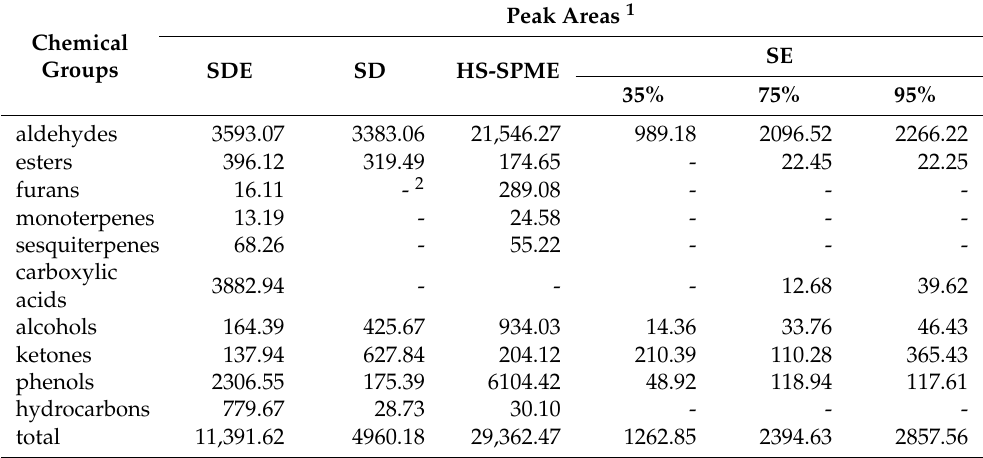
Table 1. Total peak areas of the chemical groups of vanilla pods using different extraction